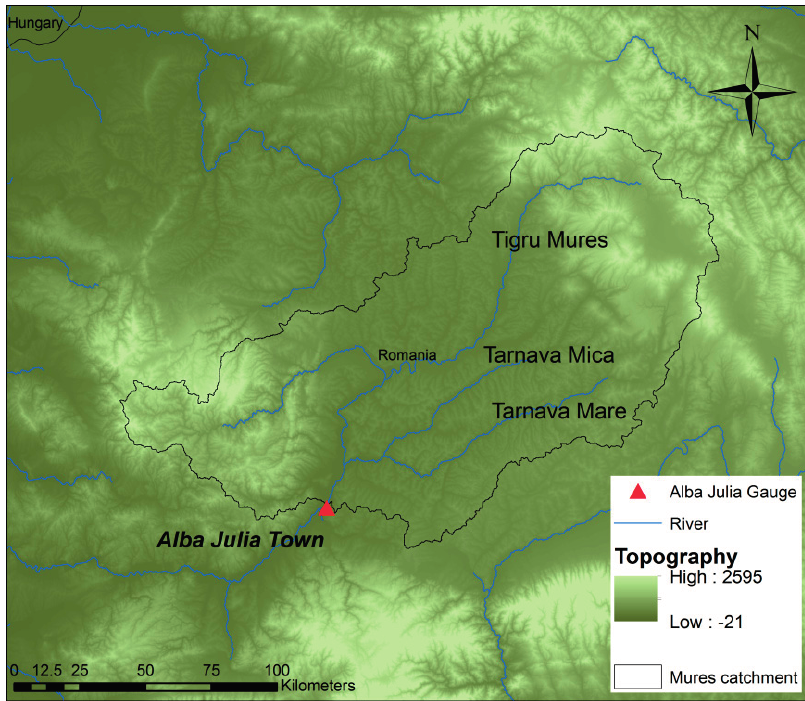
Figure 1. Mures River